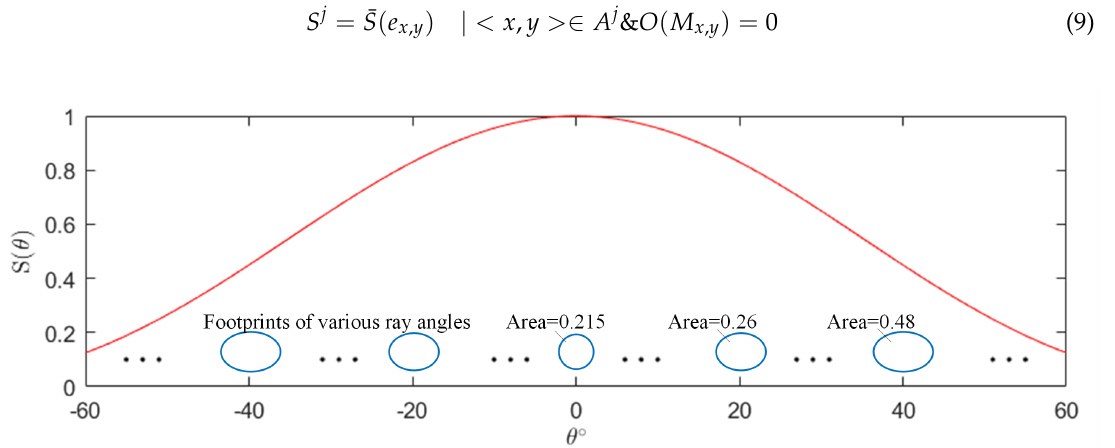
Figure 4. Sensor confidence based on footprints. The drafts of footprints in a swath are added to illustrate the origin of the curve. The labeled areas are calculated based on practical parameters, that is ¯ h = 30 m, β = 0.5 ◦ . The unit of the areas is m 2